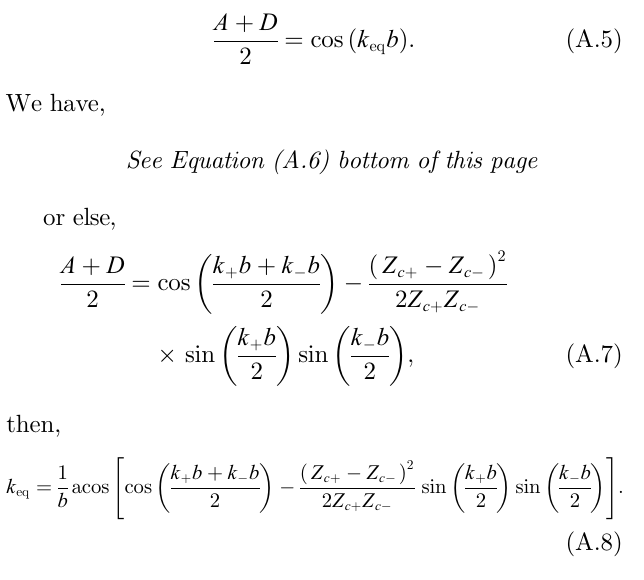
Þ : ð A : 5 Þ Figure A.2. Dispersion diagram of a string with periodically